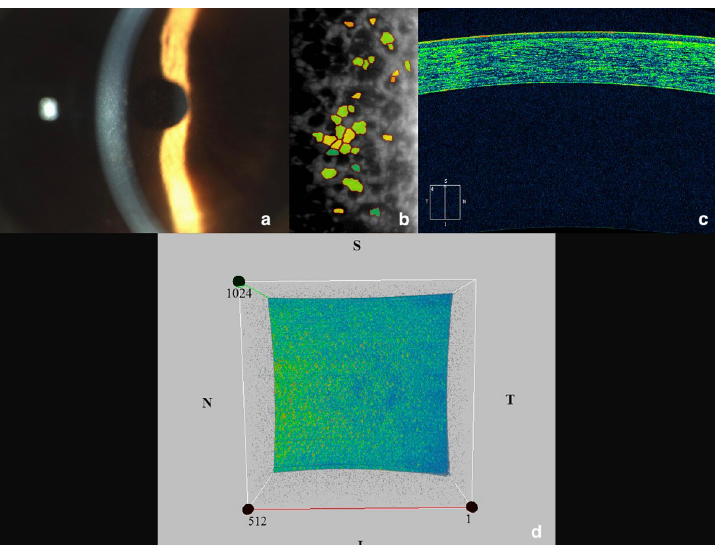
Fig 2. The study eye of a patient with moderate FECD and its related OCT pattern n. 2 (‘dotty’ appearance). (a) slit-lamp biomicroscopy showing a beaten metal-like appearance of the corneal endothelium with the characteristic confluent guttae; (b) specular endothelial microscopy confirming the loss of endothelial cells; (c) cross-sectional AS-OCT scan displaying a faint hyper-reflectivity of the corneal endothelium; (d) 3D AS-OCT image of a 512x128 cube scan showing a large number of hyper-reflective orange-yellowish points scattered through the four quadrants of the inner corneal surface.